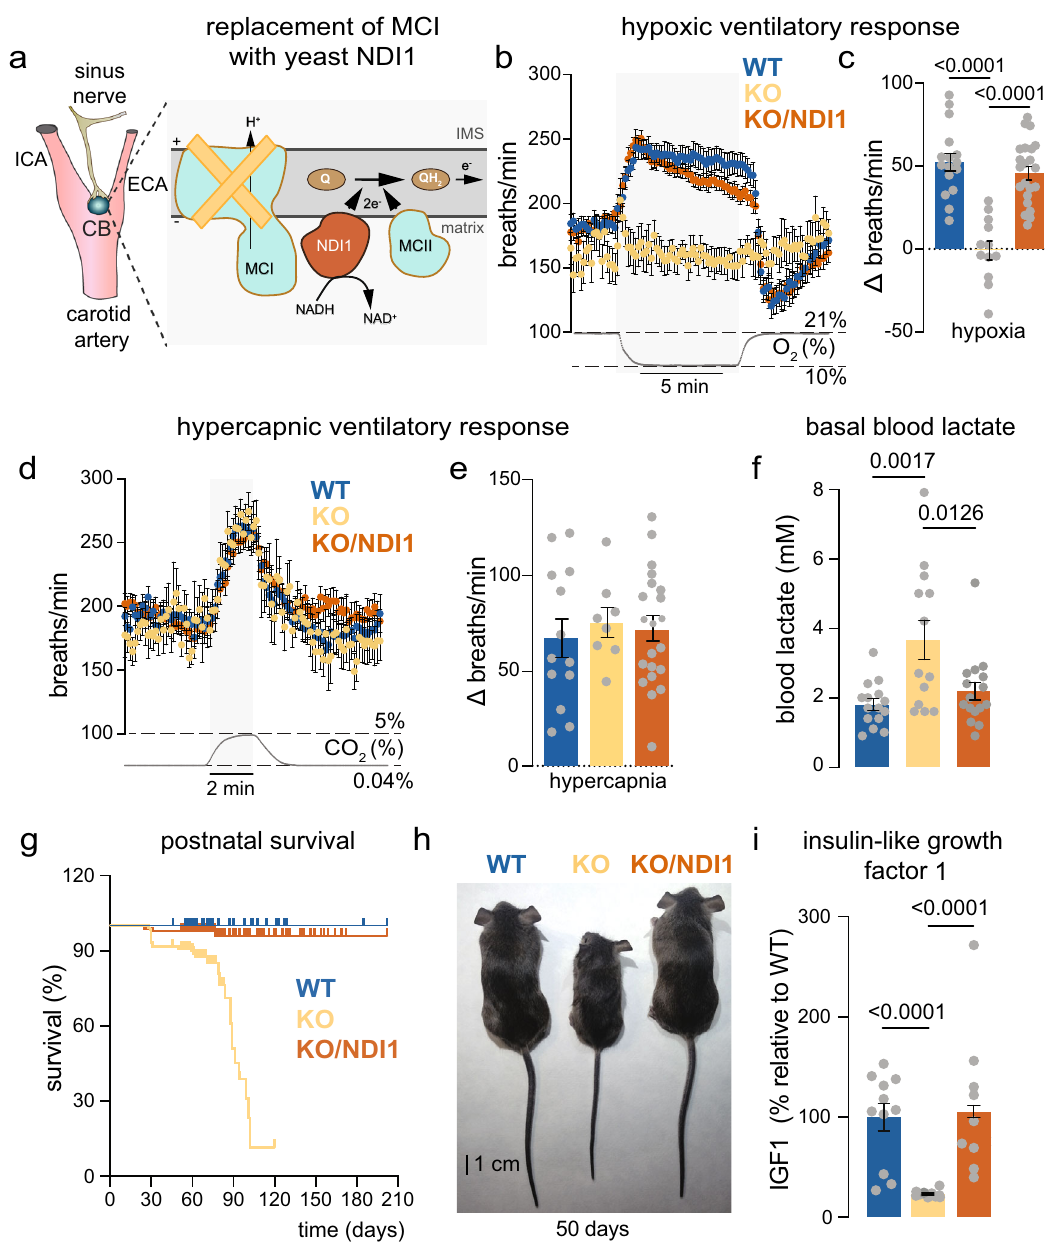
Fig. 1 | Rescue of the hypoxic ventilatory response and systemic defects by transgenic NDI1 in mitochondrial complex I-de fi cient mice. a Left. Scheme illustrating the carotid artery bifurcation and location of the carotid body (CB). ICA internal carotid artery, ECA external carotid artery. Modi fi ed from ref. 20 . Right. ReplacementofmitochondrialcomplexI(MCI)withNDI1intheKO/NDI1mouse.IMS: Intermembrane space; Q and QH 2 : oxidized and reduced forms of ubiquinone, respectively. b Hypoxic (10% O 2 ) ventilatory response (HVR, breaths/min) of the mouse strains studied (WT, n =16; KO, n =12; KO/NDI1, n =22). Each data point is represented as mean±SEM. Changes in % O 2 with time are represented at the bot- tom. c Average increase in respiratory frequency induced during hypoxia (10% O 2 , Δ breaths/min)inthethreemousemodelsstudied(WT,52±5, n =16;KO, − 1±6, n =12; KO/NDI1, 46±4, n =22). d Average hypercapnic ventilatory response (5% CO 2 , breaths/min) of the mouse strains studied (WT, n =13; KO, n =8; KO/NDI1, n =21).